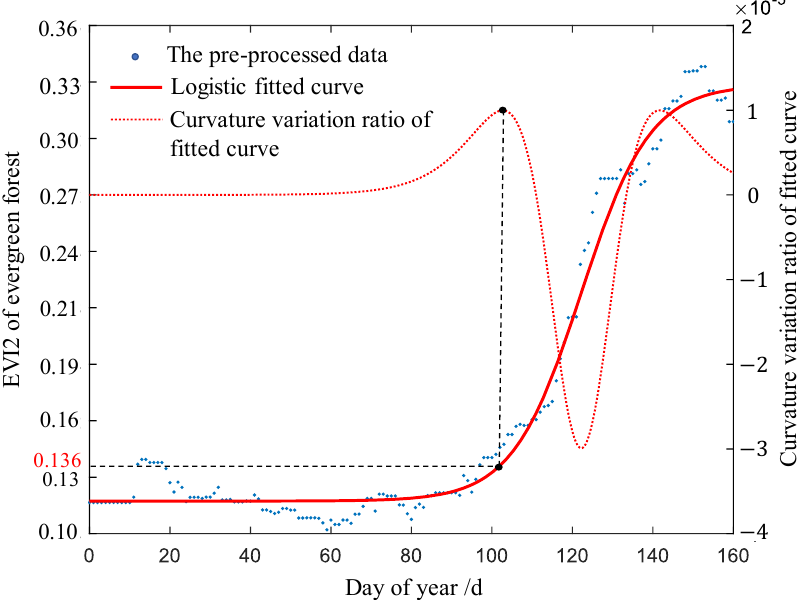
Figure 5. The EVI2 value corresponding to the green-up date of evergreen forest. The black dots correspond to the green-up date of the evergreen forest.